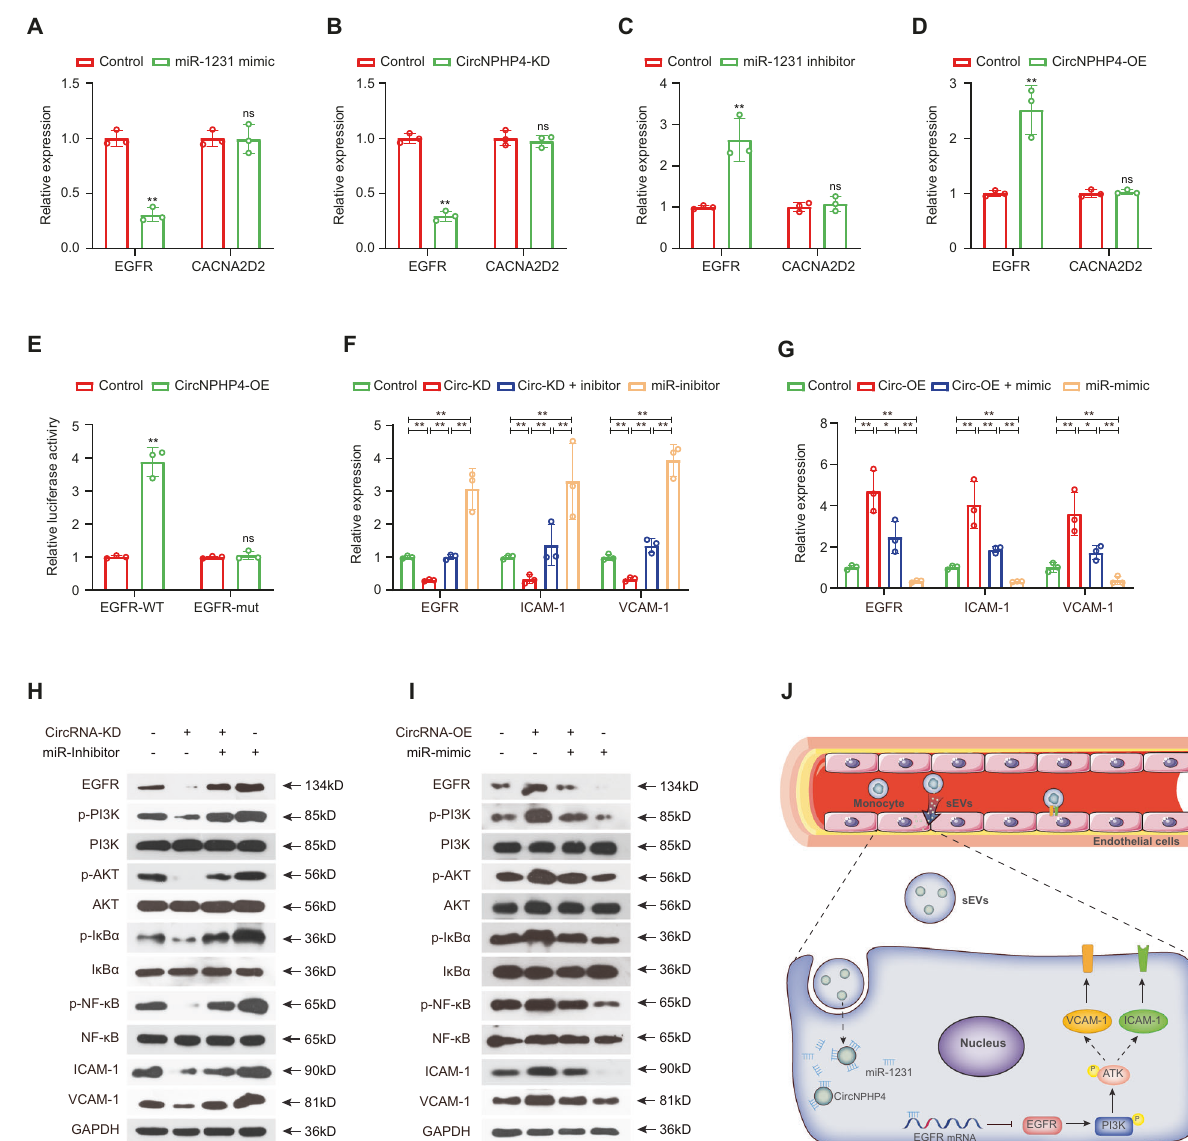
Fig. 7 CircNPHP4 promoted the EGFR/PI3K/AKT pathway through miR-1231. CircNPHP4 promoted the EGFR/PI3K/AKT pathway through miR-1231 inhibition in HCAECs qRT-PCR quanti fi cation of EGFR and CACNA2D2 expression after miR-1231 overexpression ( A ) or circNPHP4 knockdown ( B ). EGFR and CACNA2D2 expression after transfection with miR-1231 inhibitor ( C ) or circNPHP4 expression vector ( D ) was quanti fi ed with qRT-PCR. Luciferase assay where HCAEC were co-transfected with a scrambled control, circNPHP4 expression plasmid, and a luciferase reporter plasmid containing either wild-type EGFR (EGFR-WT) or an EGFR construct with mutated miR-1231 binding sites (EGFR- mut) ( E ). F – I Reversion assays using vectors overexpressing or knocking down circNPHP4, as well as miR-1231 mimics or inhibitors. Data are presented as means ± SD; a signi fi cant difference was identi fi ed with Student ’ s t test. *P < 0.05; ** P < 0.01; ns (not signi fi cant). J A proposed model illustrating the role of monocyte-derived sEVs circNPHP4 in regulating heterogeneous adhesion in vein endothelial exosomal and serum circNPHP4 expression levels are indispen- sable factors in the predictive model. When one or both of them are missing, the bene fi t obtained by using the model signi fi cantly decreased. Moreover, compared with the exosomal circNPHP4 expression level, the contribution of the serum circNPHP4 expression level to the model was greater.